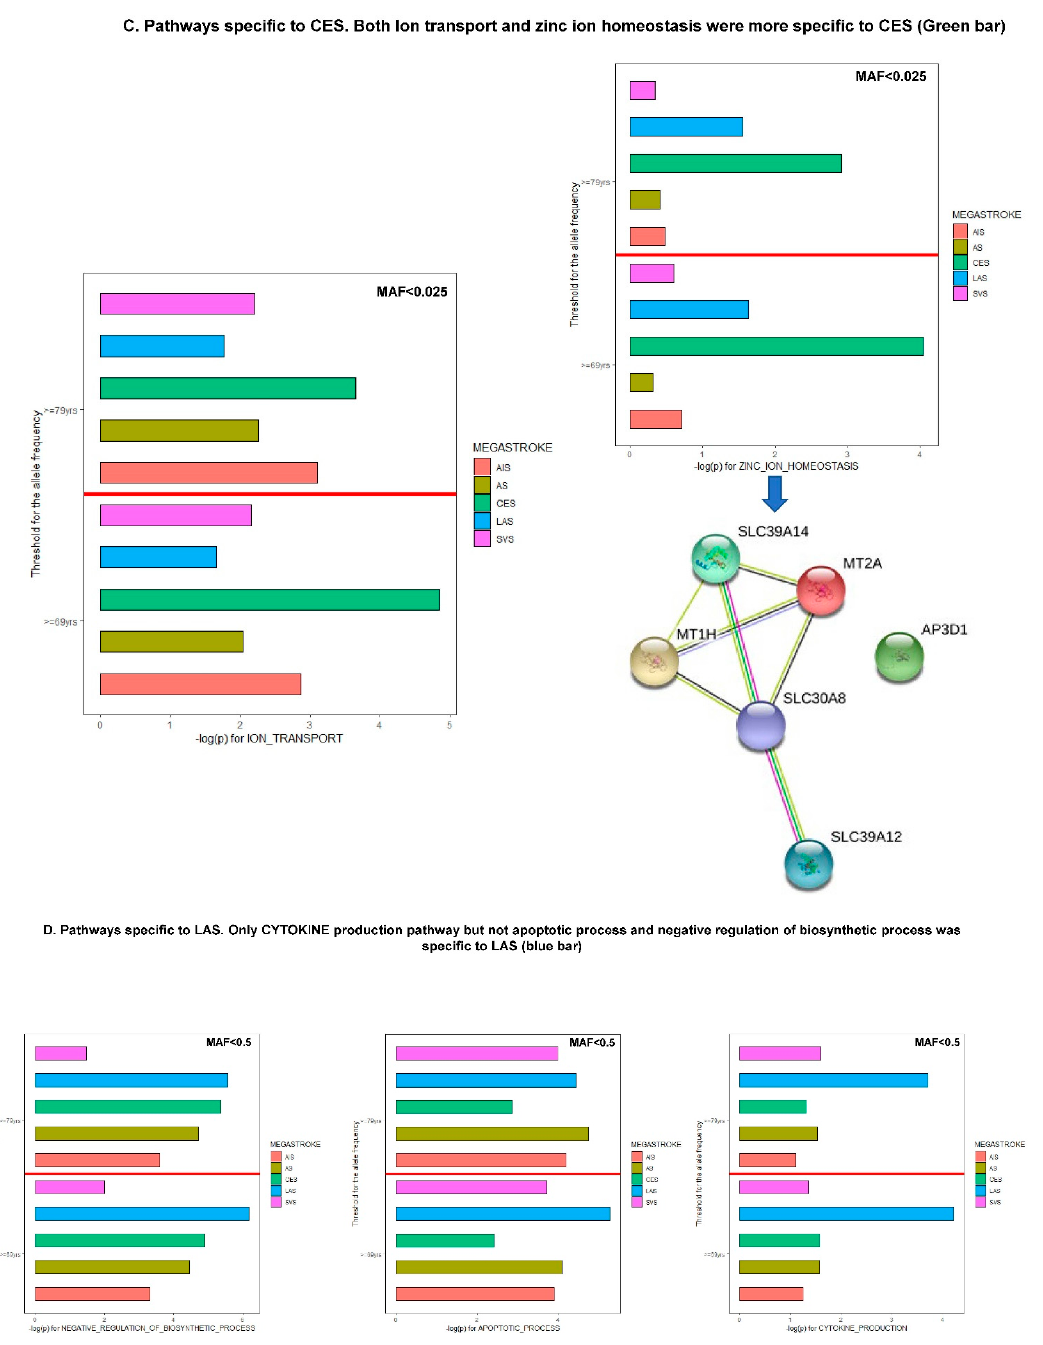
Figure 5. Pathways specific to any stroke or any ischemic stroke. Gene-set analyses illustrate the top pathways enriched for ischemic stroke when the PRS was constructed based on each of the five summary statistics of MEGASTROKE (color of the bars) stratified by controls with index age ≥ 69yrs or 79 yrs, as shown in the y -axis. Here, we selected the VEGF signaling pathway, regulation of amyloid precursor protein catabolic process, and negative regulation of interleukin 2 production as examples to show the specificity of these pathways significantly enriched only for the PRS constructed by the polygenic architecture of MEGASTROKE AS or AIS. PRS was constructed under two levels of MAF thresholding. Here, we only chose MAF ≤ 0.025 as an example to show that these pathways were the top pathways under this condition. All the raw p values in the x-axis demonstrate the significance of the enriched signals against the background without correction for multiple testing. The gene network that harbors those genetic risks with a moderate effects size for ischemic stroke ( p < 0.1) were illustrated using String-db. Here, we chose genes included in the VEGF signaling pathway as an